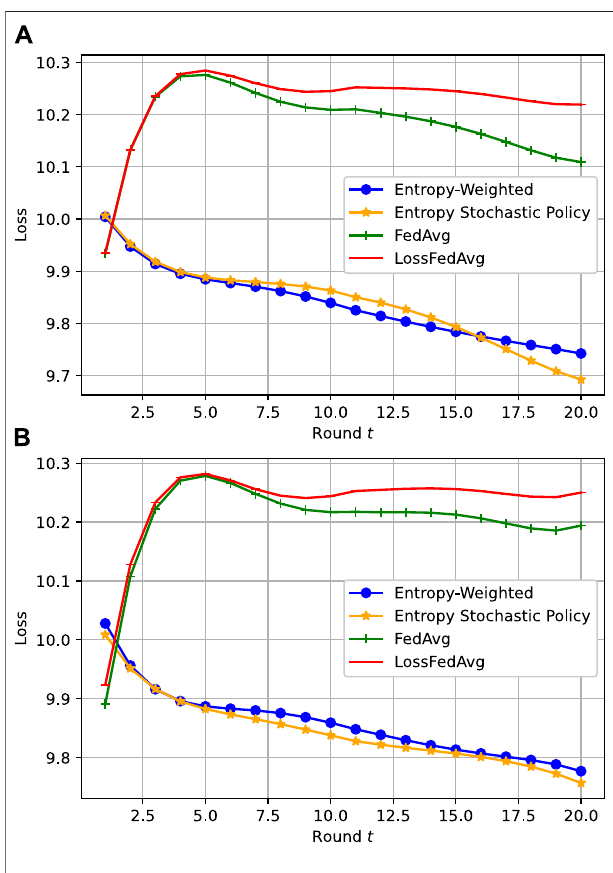
FIGURE 6 | FL training loss vs. number of rounds for η (cid:1)